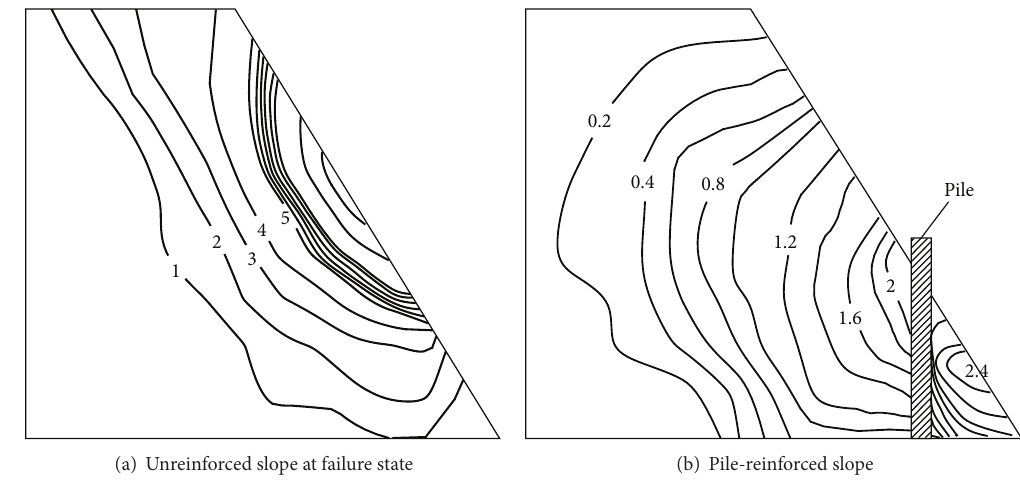
Figure 2: Horizontal displacement contours of slopes at 50g-level (unit: